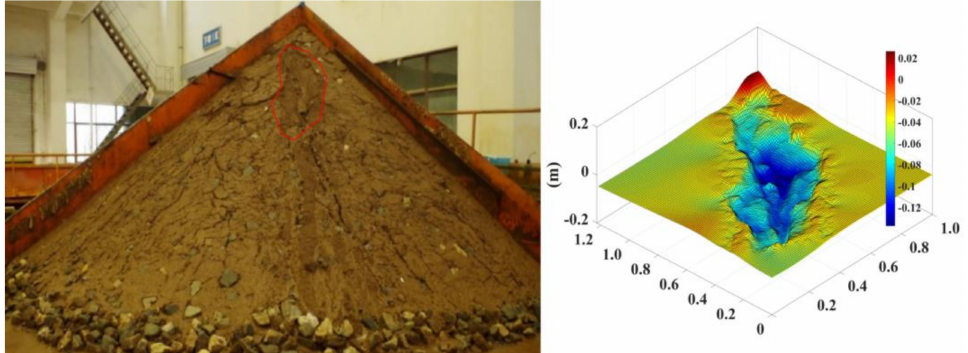
Figure 3. Photograph of spoil heap after the second rainfall at 90 mm/h intensity and the DEM of the landslide